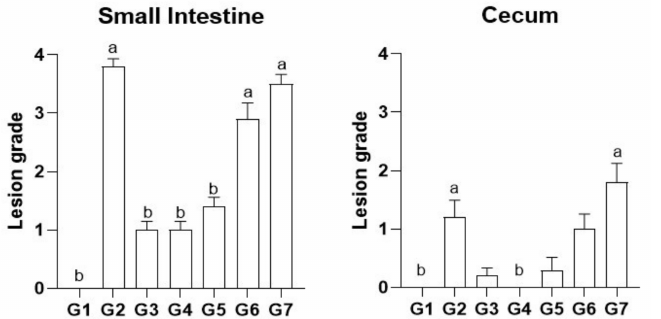
Figure 6. Histological scoring of Eimeria spp. lesions in chickens prophylactically treated with toltrazuril formulations. Data expressed as means ± SD ( n = 9–10 per group); a p < 0.05 vs. G1 and b p < 0.05 vs. G2 (non-parametric Kruskal–Wallis test, post hoc Dunn’s test). G1 = con- trol ( − ); G2 = control (+); G3 = Baycox ® (7 mg/kg/day); G4 = LNCt (7 mg/kg/day); G5 = LNCt (3.5 mg/kg/day); G6 = LNCt (1.75 mg/kg/day); G7 = LNC (volume equivalent to